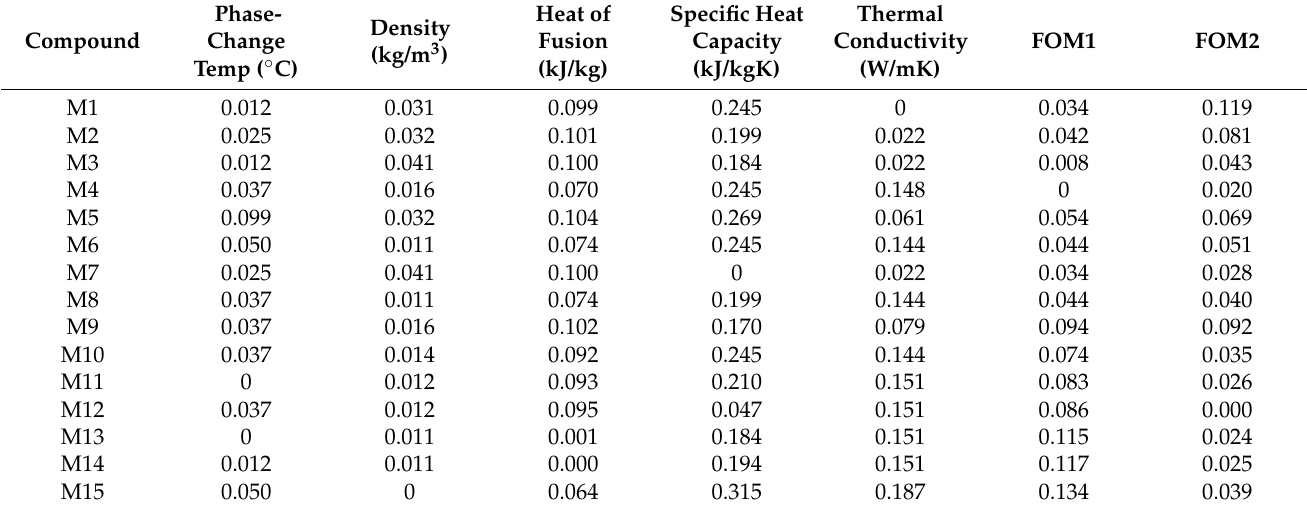
Table 10. VIKOR calculations.